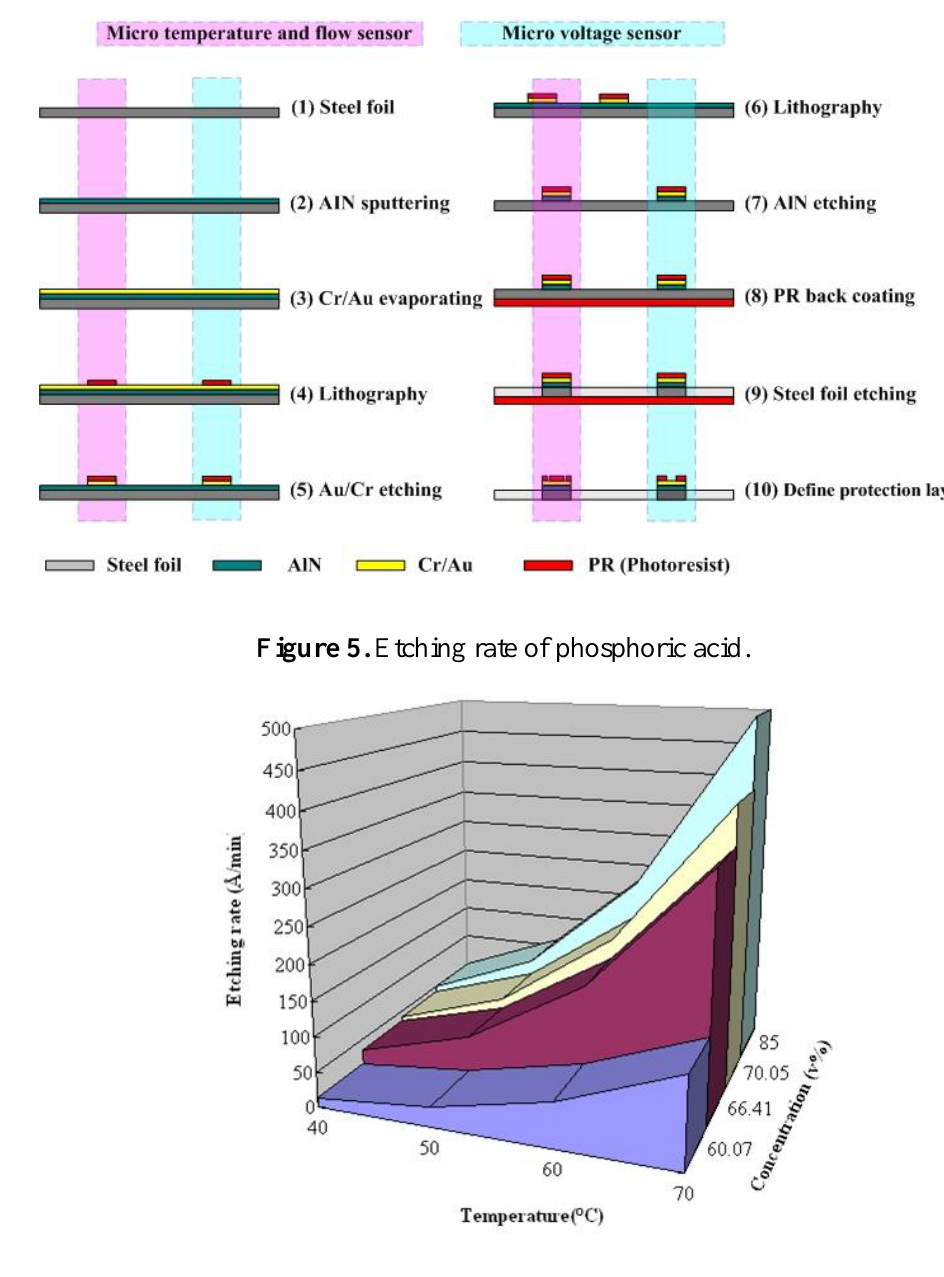
Figure 4. Process of fabricating multi-functional flexible micro-sensors.